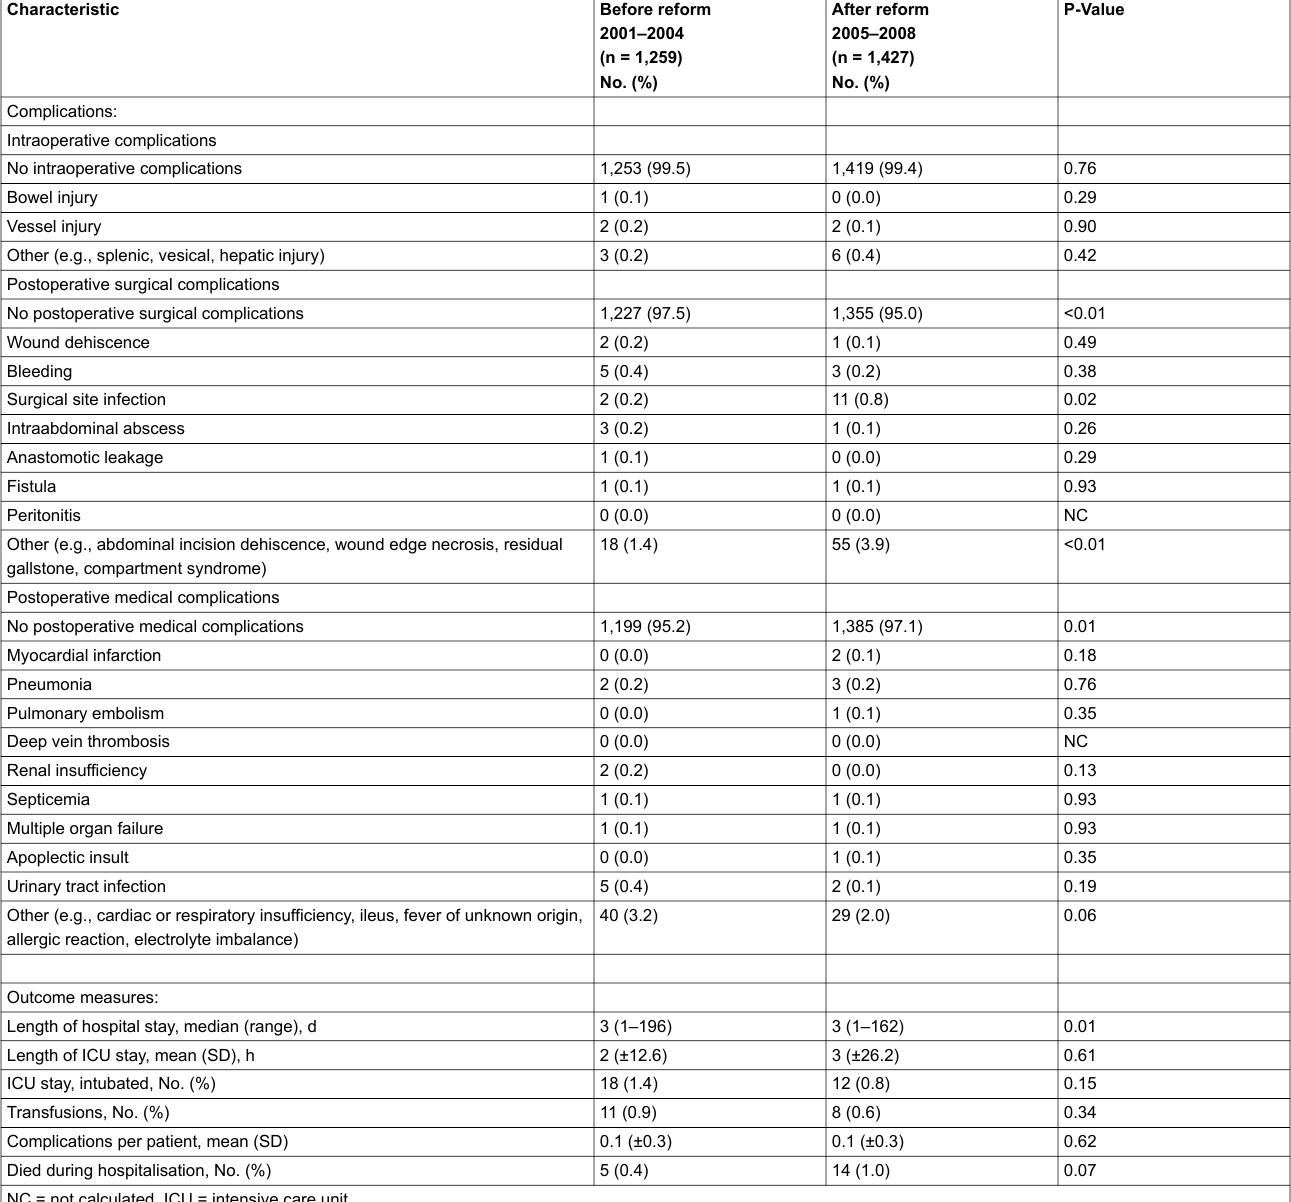
Table 2: Univariate analysis of intraoperative, postoperative surgical and medical complications and outcome measures (n = 2,686).